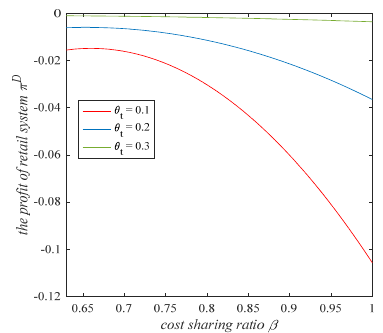
Figure 12. Profit of retail system in Scenario D (1).